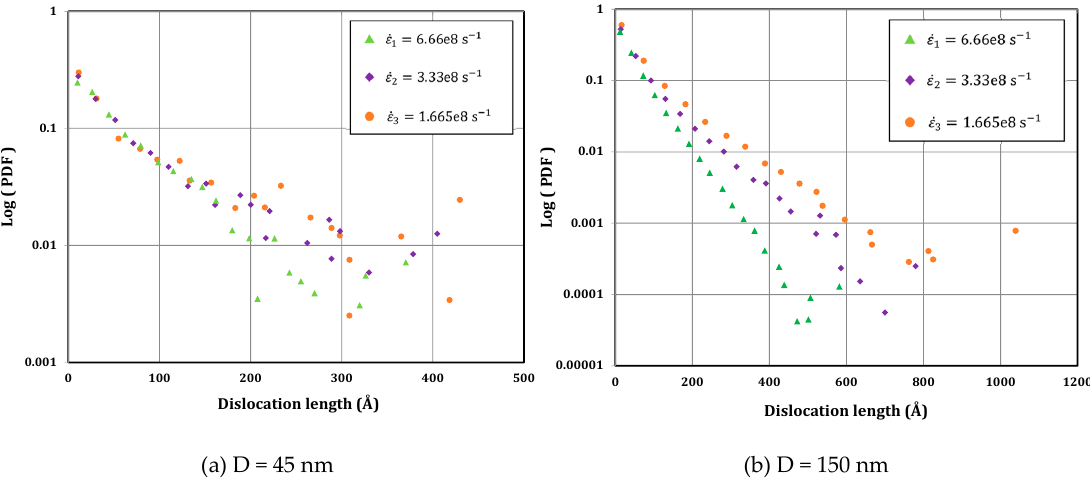
Figure 23. The responses of pillars with D = 45 nm and D = 150 nm during micropillar compression test with different strain rates of: ( a ) 𝜀(cid:4662) (cid:2869) (cid:3404) 6.66 (cid:3400) 10 (cid:2876) s (cid:2879)(cid:2869) ; ( b ) 𝜀(cid:4662) (cid:2870) (cid:3404) 3.33 (cid:3400) 10 (cid:2876) s (cid:2879)(cid:2869) ; ( c ) 𝜀(cid:4662) (cid:2871) (cid:3404) 1.665 (cid:3400) 10 (cid:2876) s (cid:2879)(cid:2869) (after Voyiadjis and Yaghoobi [16]).